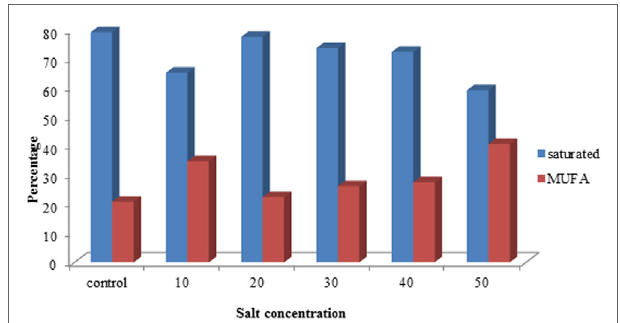
FigUre 4 | comparison of FaMe concentration of saturated and monounsaturated fatty acid profile of Scenedesmus quadricauda under salt stress